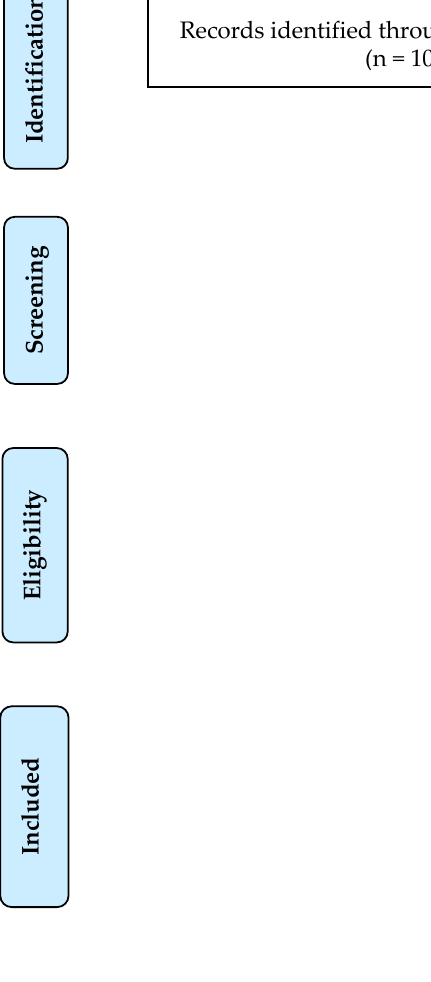
Figure A1. Study selection flow